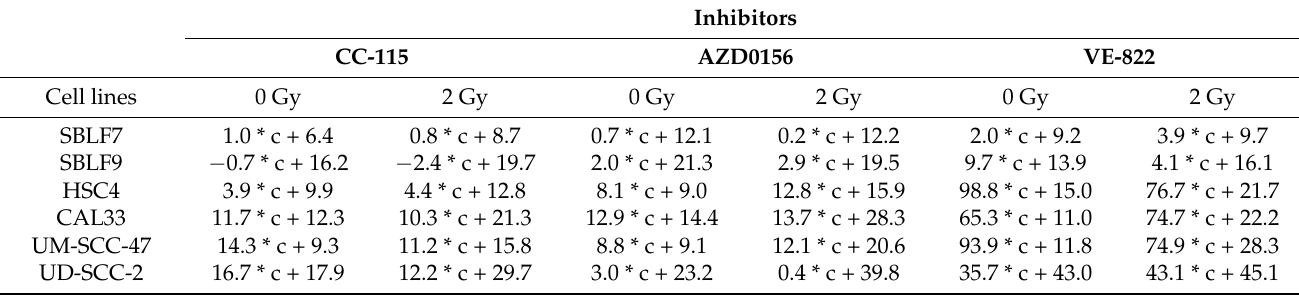
Table 1. Cell death in the form of apoptosis and necrosis induction according to the equation: cell death = m*c + b; where m is the slope, c is the concentration of the inhibitor, b is the offset, and * stands for